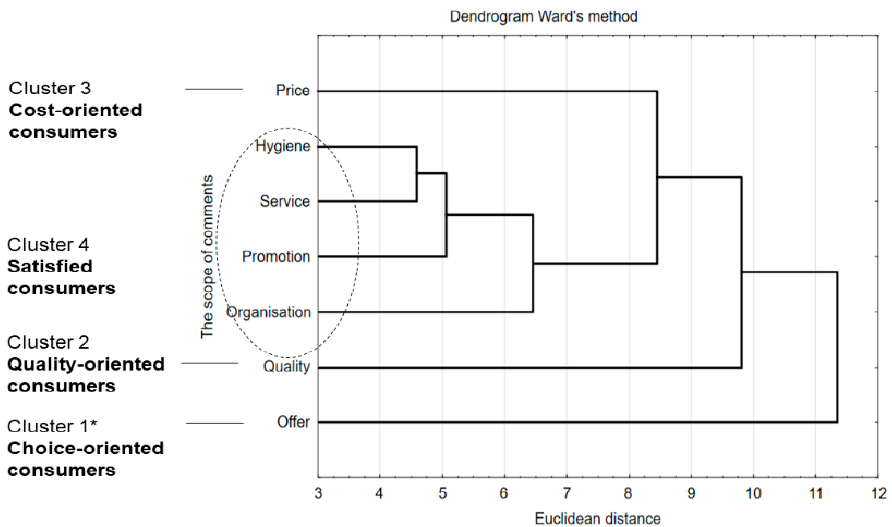
Figure 4. Consumer profile referring to comments about staff canteens; * clusters numbered depending on their importance for consumers. on their importance for